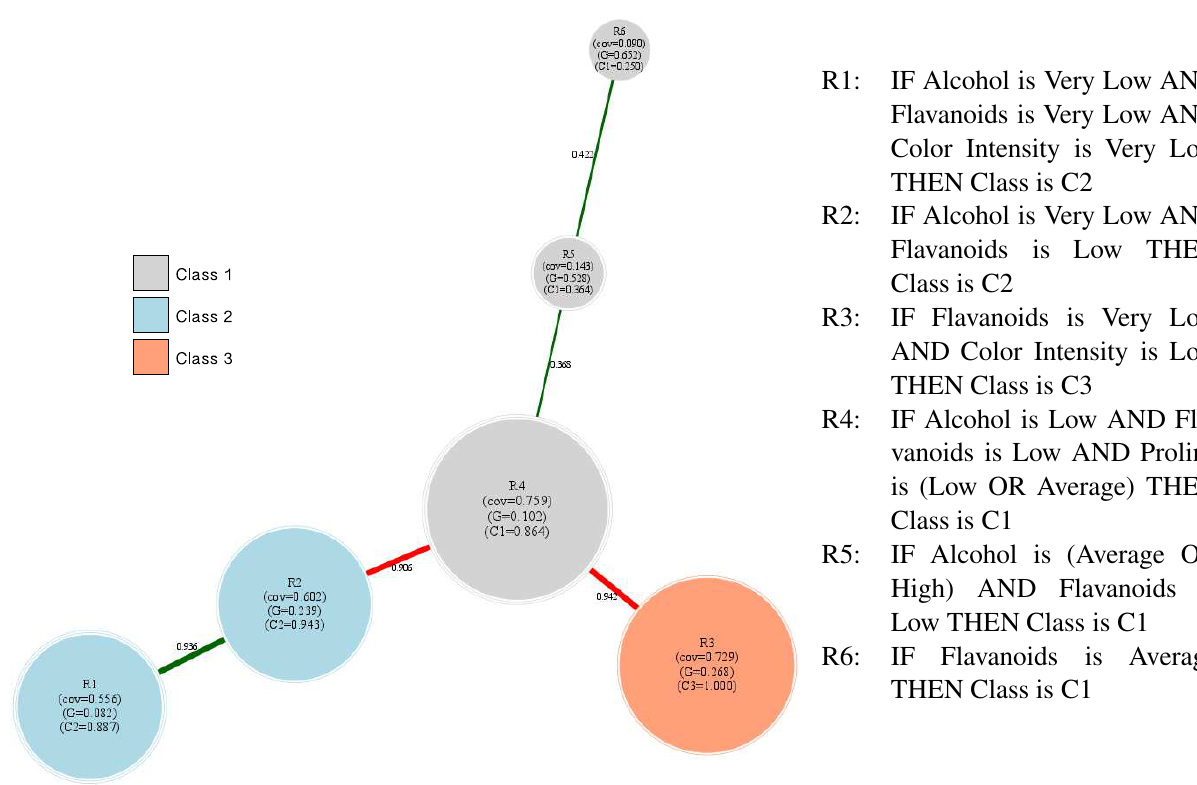
Figure 7: Fingram of the simplified